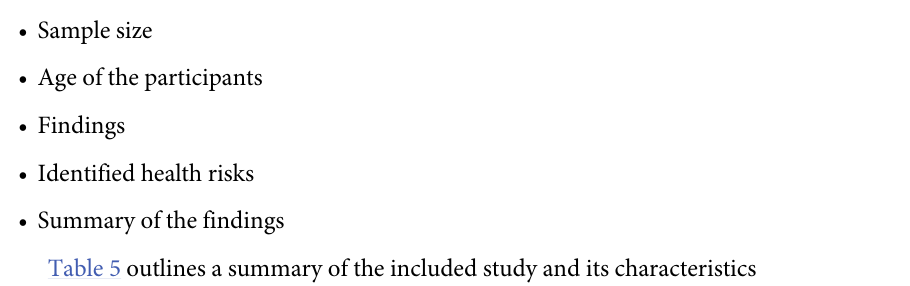
Table 5 outlines a summary of the included study and its